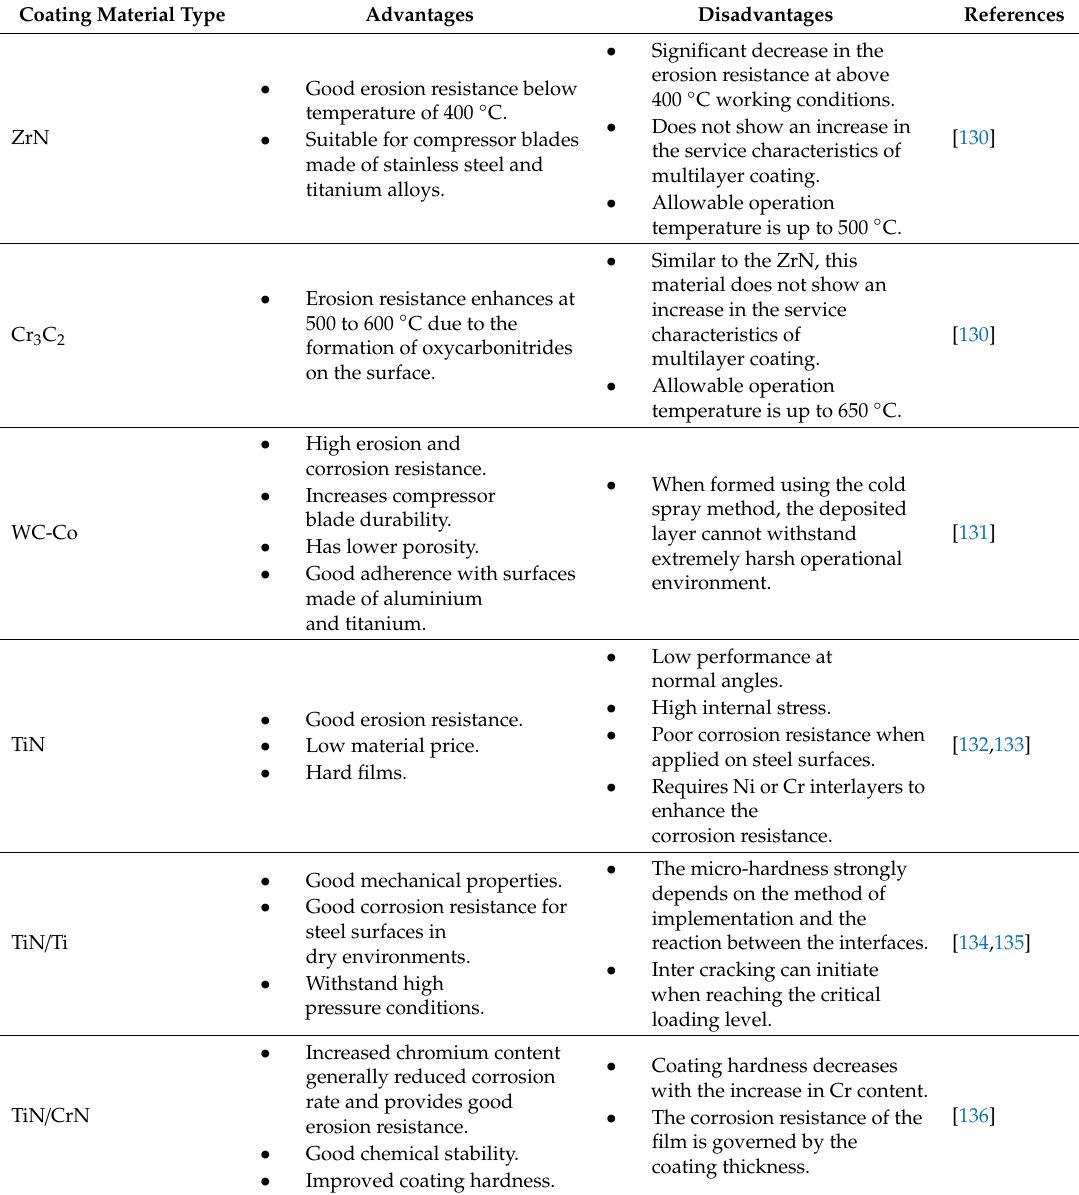
Table 5. Example of some of the coating materials used for compressor blades. Coating Material